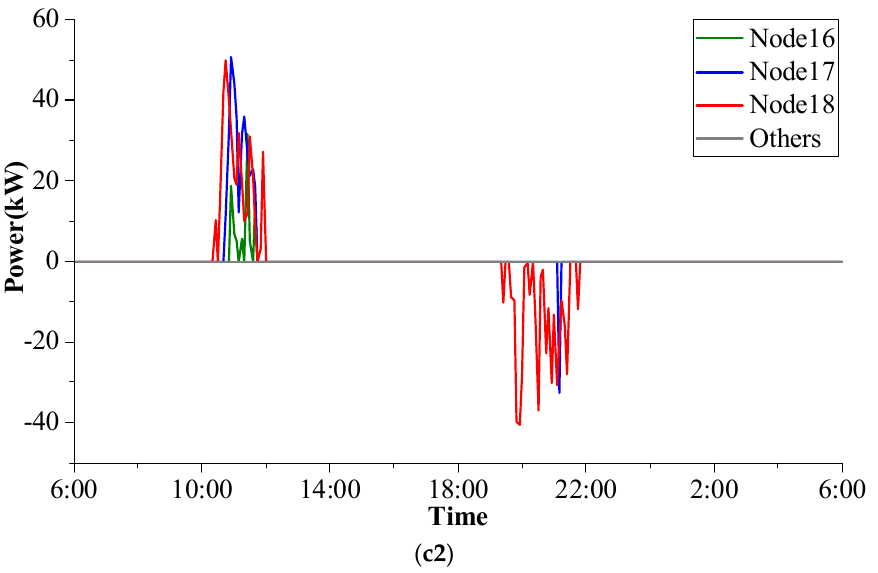
Figure 10. The voltages curves of nodes and regulation power with the voltage optimization of the sensitivity coefficient method and the successive voltage regulation algorithm: ( a1 ) Over-voltage optimization by the sensitivity coefficient method. ( a2 ) Over-voltage optimization by the successive voltage regulation algorithm. ( b1 ) Under-voltage optimization by the sensitivity coefficient method. ( b2 ) Under-voltage optimization by the successive voltage regulation algorithm. ( c1 ) The regulation power calculated by the sensitivity coefficient method. ( c2 ) The regulation power calculated by the successive voltage regulation algorithm.